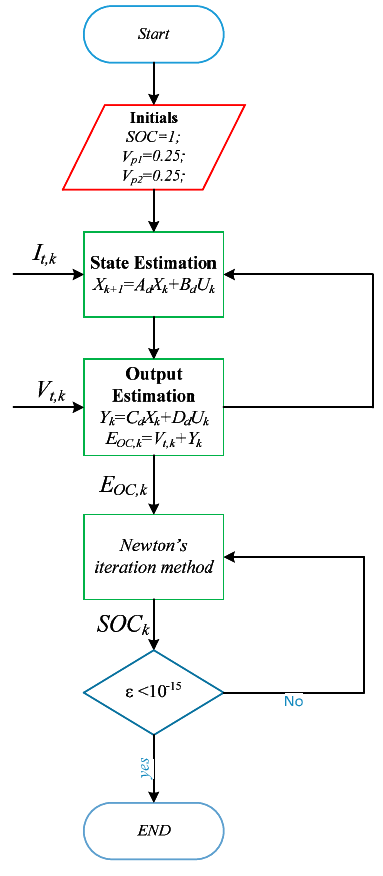
Figure 2. Algorithm for estimating state-of-charge (SOC) of the Li-ion battery using Newton’s iteration method.